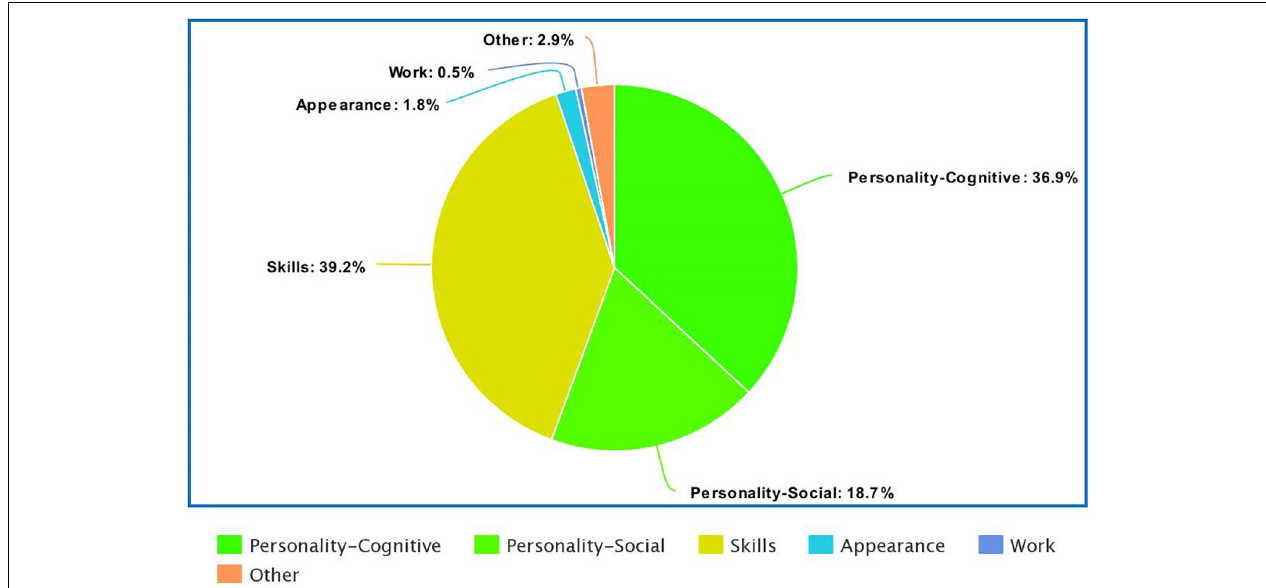
FIGURE 2 | Types of descriptions of scientists (organized by